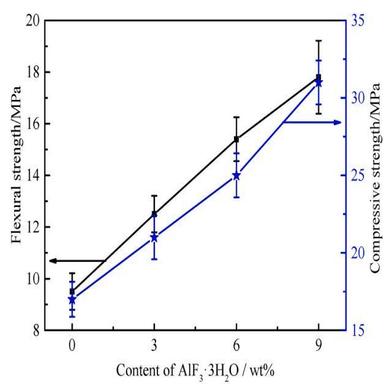
Effect of the AlF3⋅3H2O contents on the mechanical strength of lightweight porous materials.